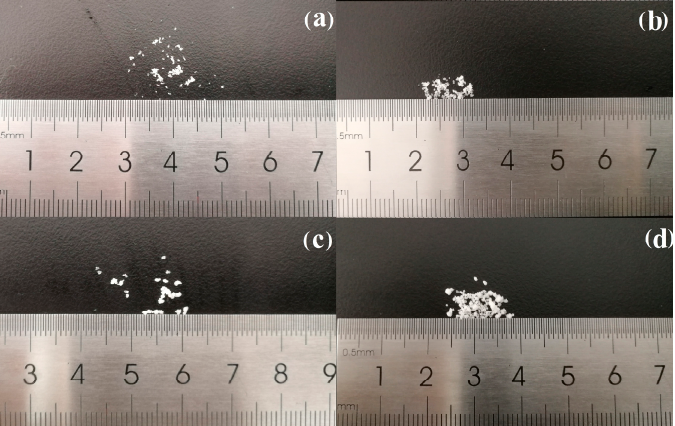
Figure 9. Particle images of final products of GTA under different stirring speeds (( a ) 140 r/min, ( b ) 120 r/min, ( c ) 100 r/min, ( d ) 80 r/min).